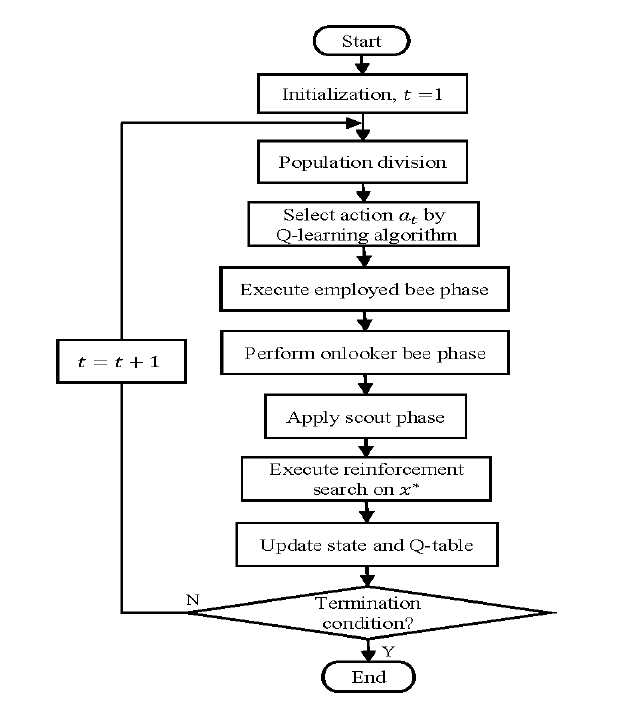
Figure 9. The flowchart of